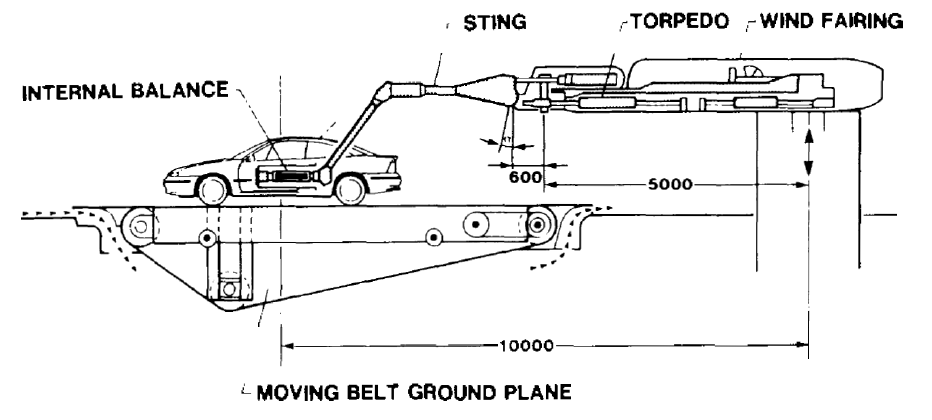
Figure 2. Experimental setup by Mercker et al. [13].